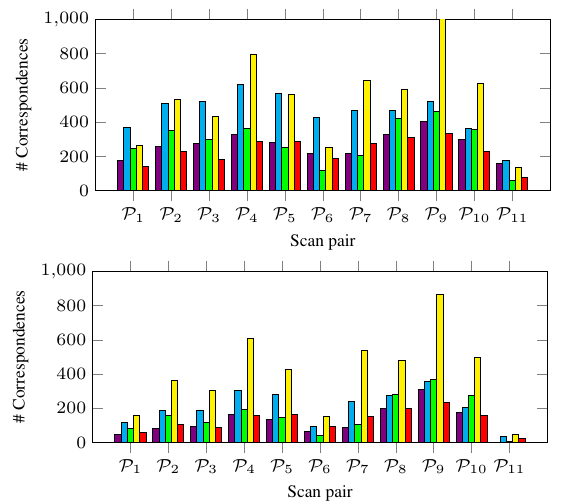
Figure 6. Number of feature correspondences used for the coarse registration (top) and for the fine registration (bottom) of scan pairs P j = {S j , S j +1 } : SIFT (violet), SURF (cyan), ORB (green), A-KAZE + M-SURF (yellow), SURF ∗ + BinBoost (red).